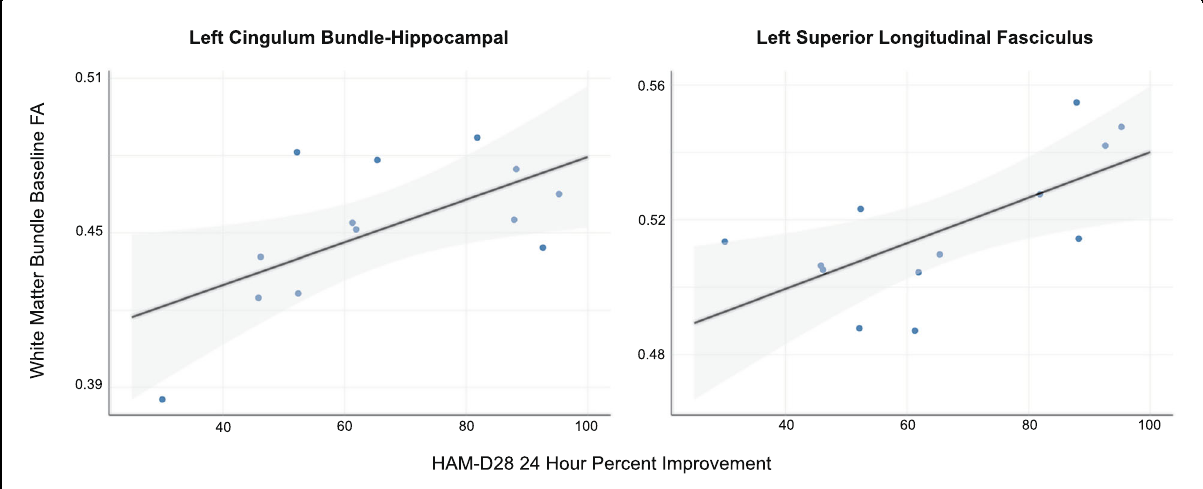
Fig. 2 Pre-infusion white matter bundle FA and depression improvement. The relationship between baseline (pre-infusion) white matter FA and clinical improvement at 24 h shown for the left cingulum bundle-hippocampal portion and the left superior longitudinal